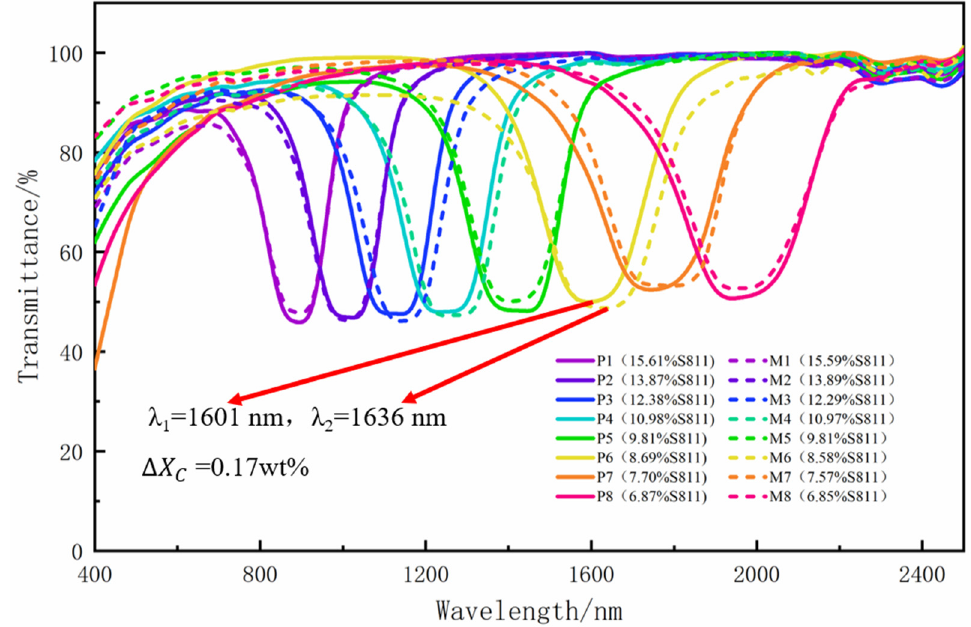
Figure 4. Comparison of the transmission spectra of the handmade sample (M) and the printed sample (P). Table 1. Composition of the actual printed Ch-LC mixture. Sample No.